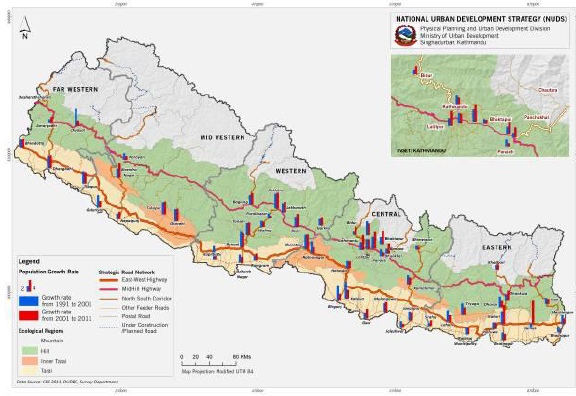
Figure 2. Urban population growth rate of Nepal. © NUDS,